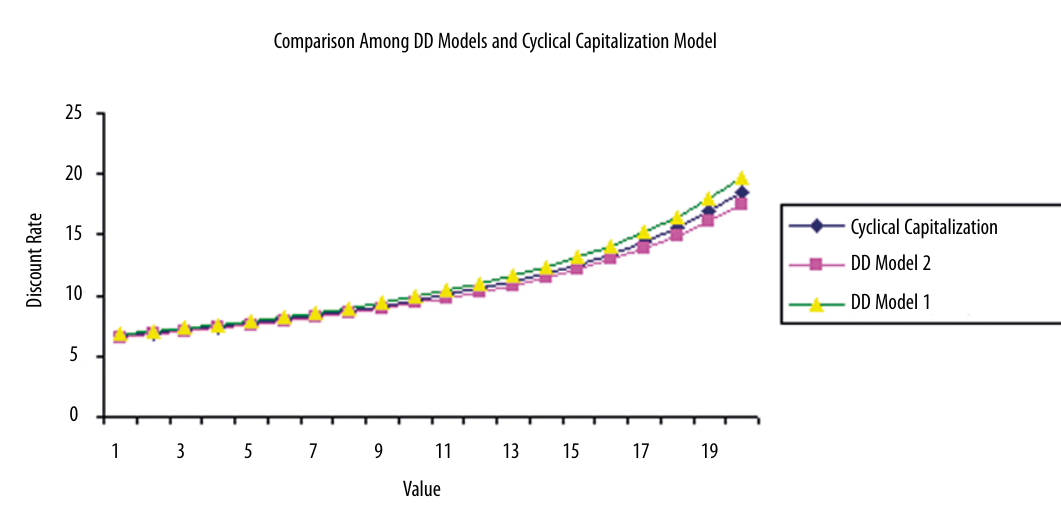
fig. 6. comparison among the opinion of value based on the cyclical capitalization and the opinions of value based on the dividend discount